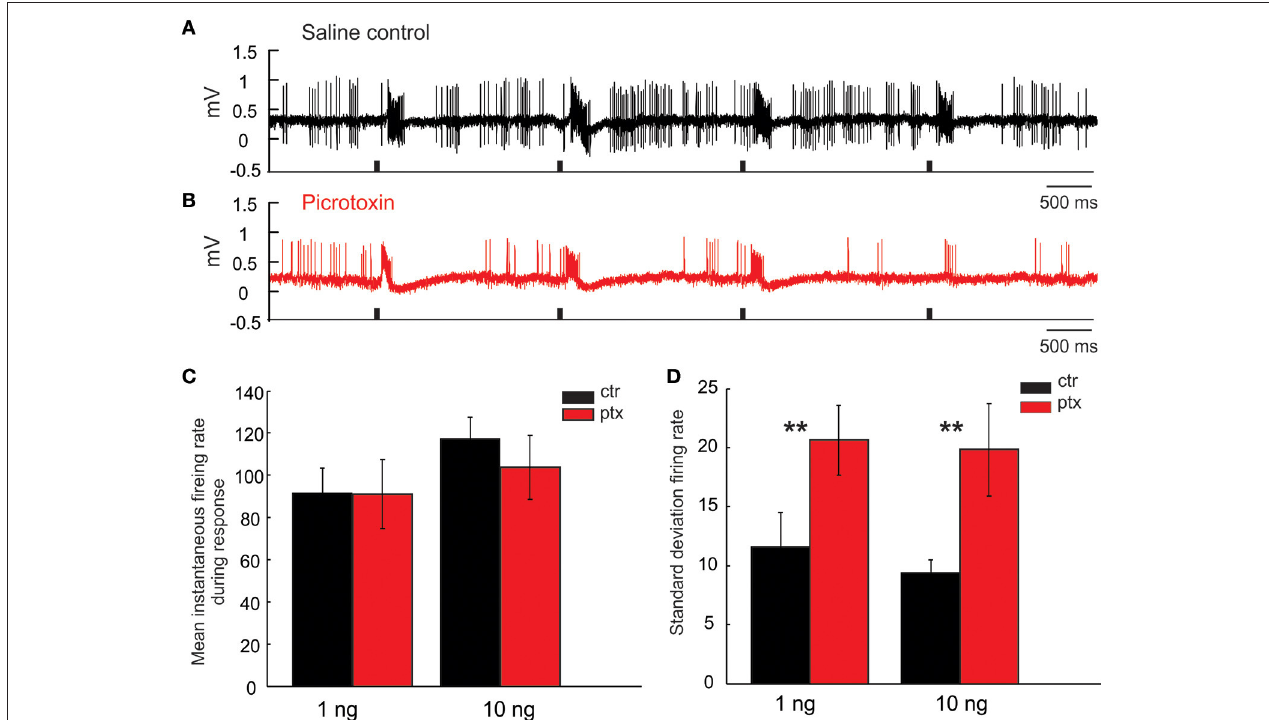
FIGURE 10 | Picrotoxin increases response variations. (A,B) Juxtacellular recording traces show the responses of a Toroid PN to four pulses of EZ stimulation under saline control (black trace) and picrotoxin treatment (red trace). (C,D) Picrotoxin does not significantly change the mean instantaneous firing rate during the response window either to 1 or 10ng stimulation; however, the treatment significantly increases the response variation measured by the standard deviation of firing rate across odor pulses ( Mann Whitney U -test, p < 0.01 , n = 8 ; asterisks indicate the significance level).